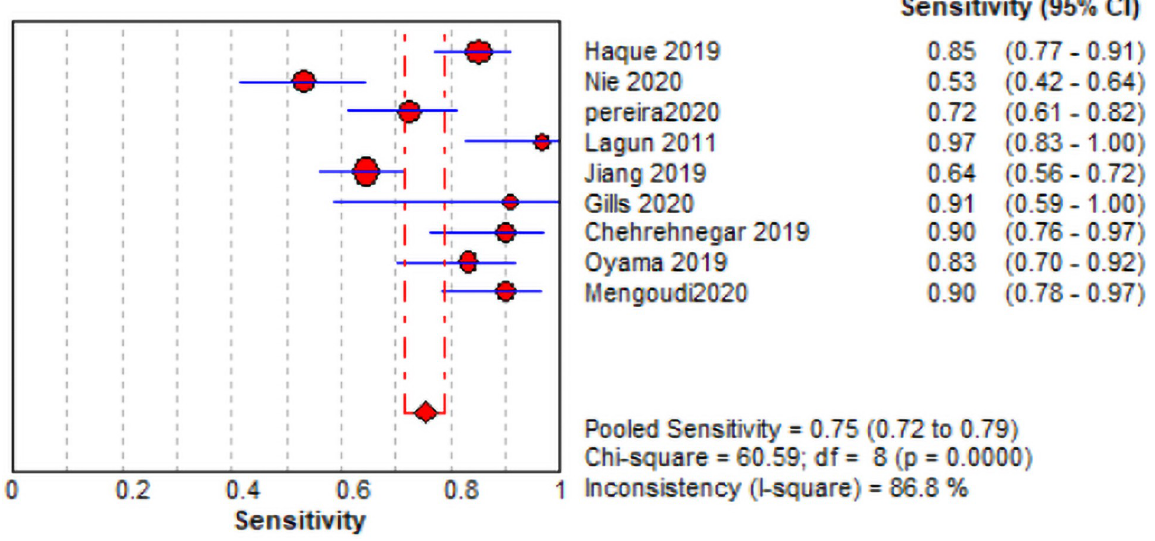
Fig 4. Forest sensitivity map (red diamond) and 95% CI (blue horizontal line).